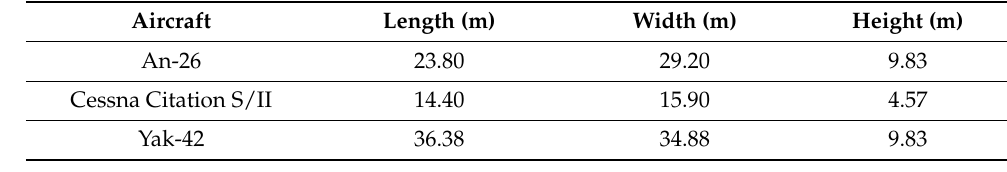
Table 1. Parameters of the aircraft.